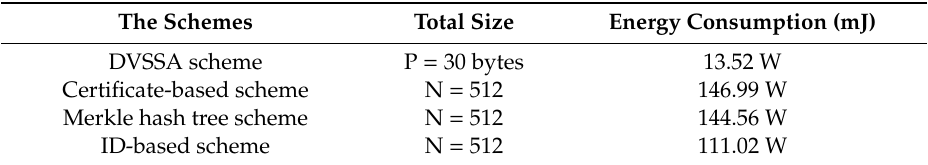
Table 2. Energy consumption on communications.